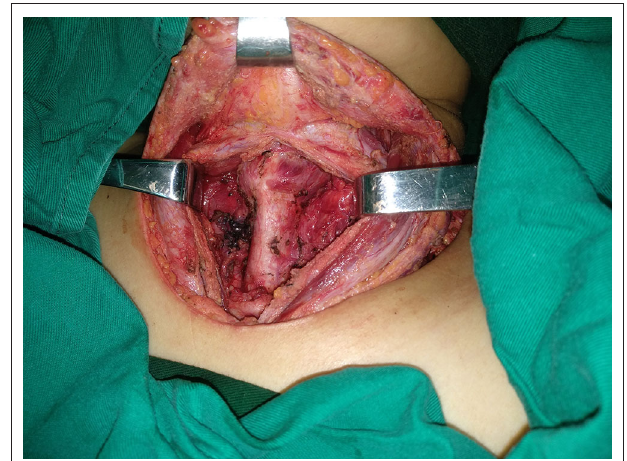
FIGURE 1 | A picture showing total